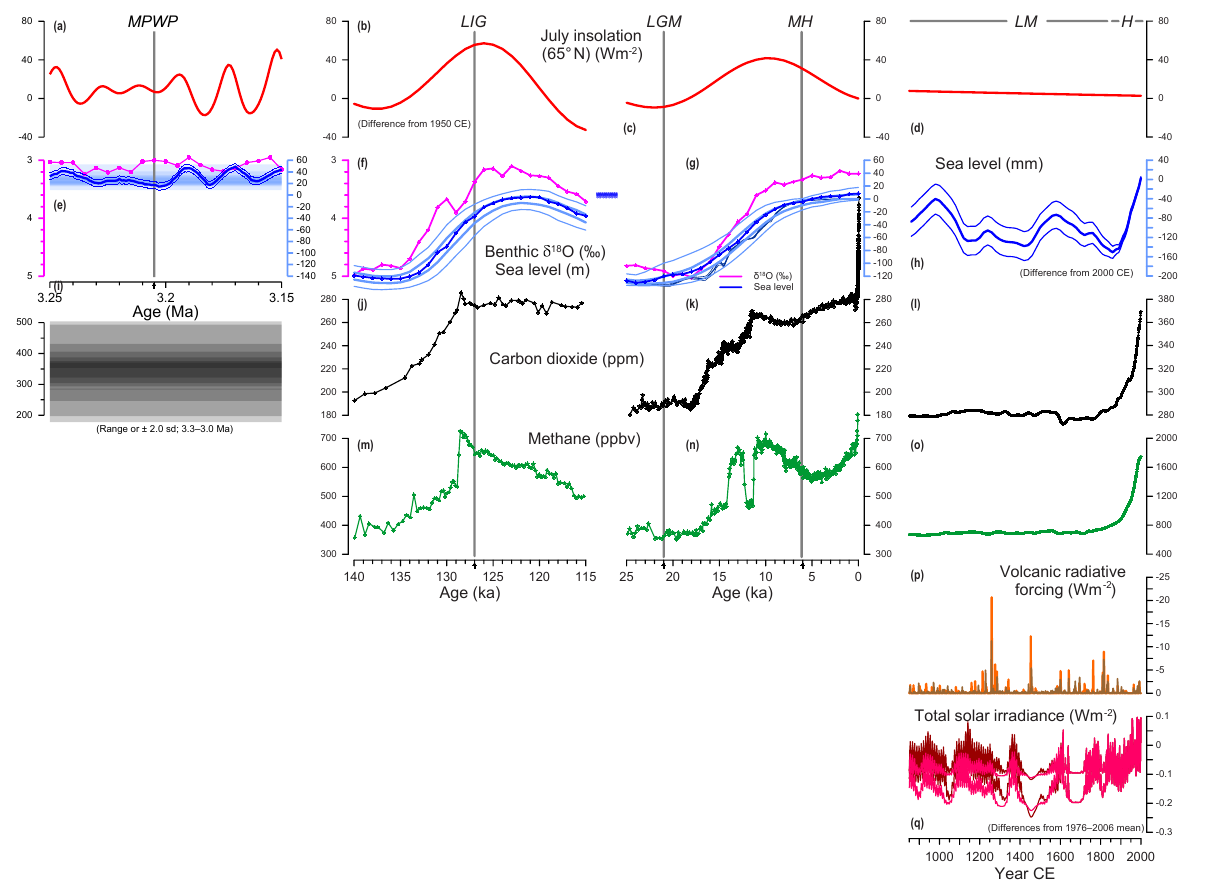
Figure 1. Context of the PMIP4 experiments (from left to right: mPWP, mid-Pliocene Warm Period; LIG, Last Interglacial; LGM, Last Glacial Maximum; MH, mid-Holocene; LM, last millennium; H, CMIP6 historical simulation): (a–d) insolation anomalies (differences from 1950CE), for July at 65 ◦ N, calculated using the programs of Laskar et al. (2004, panel a ) and Berger (1978, panels b–d ); (e) δ 18 O (magenta, Lisiecki and Raymo, 2005, scale on the left), and sea level (blue line, Rohling et al., 2014; blue shading, a density plot of 11 mid-Pliocene sea-level estimates from Dowsett and Cronin, 1990; Wardlaw and Quinn, 1991; Krantz, 1991; Raymo et al., 2009; Dwyer and Chandler, 2009; Naish and Wilson, 2009; Masson-Delmotte et al., 2013; Rohling et al., 2014; Dowsett et al., 2016. Scale on the right); (f) and (g) δ 18 O (magenta, Lisiecki and Raymo, 2005, δ 18 O scale on the left), and sea level (blue dots, with light-blue 2.5, 25, 75, and 97.5 percentile bootstrap confidence intervals, Spratt and Lisiecki, 2016; blue rectangle, LIG high-stand range, Dutton et al., 2015; dark blue lines, Lambeck et al., 2014, sea-level scale on the right in panel g ), (h) sea level (Kopp, et al., 2016, scale on the right); (i) CO 2 for the interval 3.0–3.3Ma shown as a density plot of eight mid-Pliocene estimates (Raymo et al., 1996; Stap et al., 2016; Pagani et al., 2010; Seki et al., 2010; Tripati et al., 2009; Bartoli et al., 2011; Seki et al., 2010; Kurschner et al., 1996); (j, k) CO 2 measurements (Bereiter et al., 2015, scale on the left); (l) CO 2 measurements (Schmidt et al., 2011, scale on the right); (m, n) CH 4 measurements (Loulergue et al., 2008, scale on the left); (o) CH 4 measurements (Schmidt et al., 2011, scale on the right); (p) volcanic radiative forcing (Schmidt et al., 2012, scale on the right); (q) total solar irradiance (Schmidt et al., 2012, scale on the